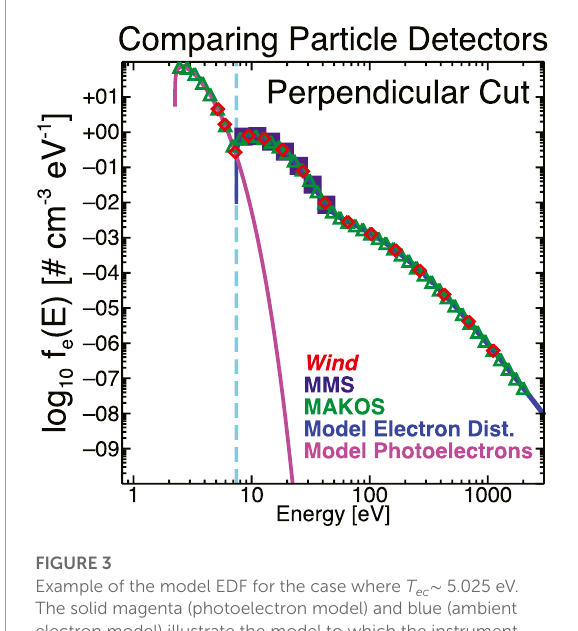
FIGURE 3 Example of the model EDF for the case where T ec ∼ 5.025 eV. The solid magenta (photoelectron model) and blue (ambient electron model) illustrate the model to which the instrument energy bins are interpolated. Three instruments are shown from Wind (red diamonds), MMS (purple squares), and the mission concept MAKOS (green triangles). The instrument energy bins are discussed in more detail in Section 7.1.1 .